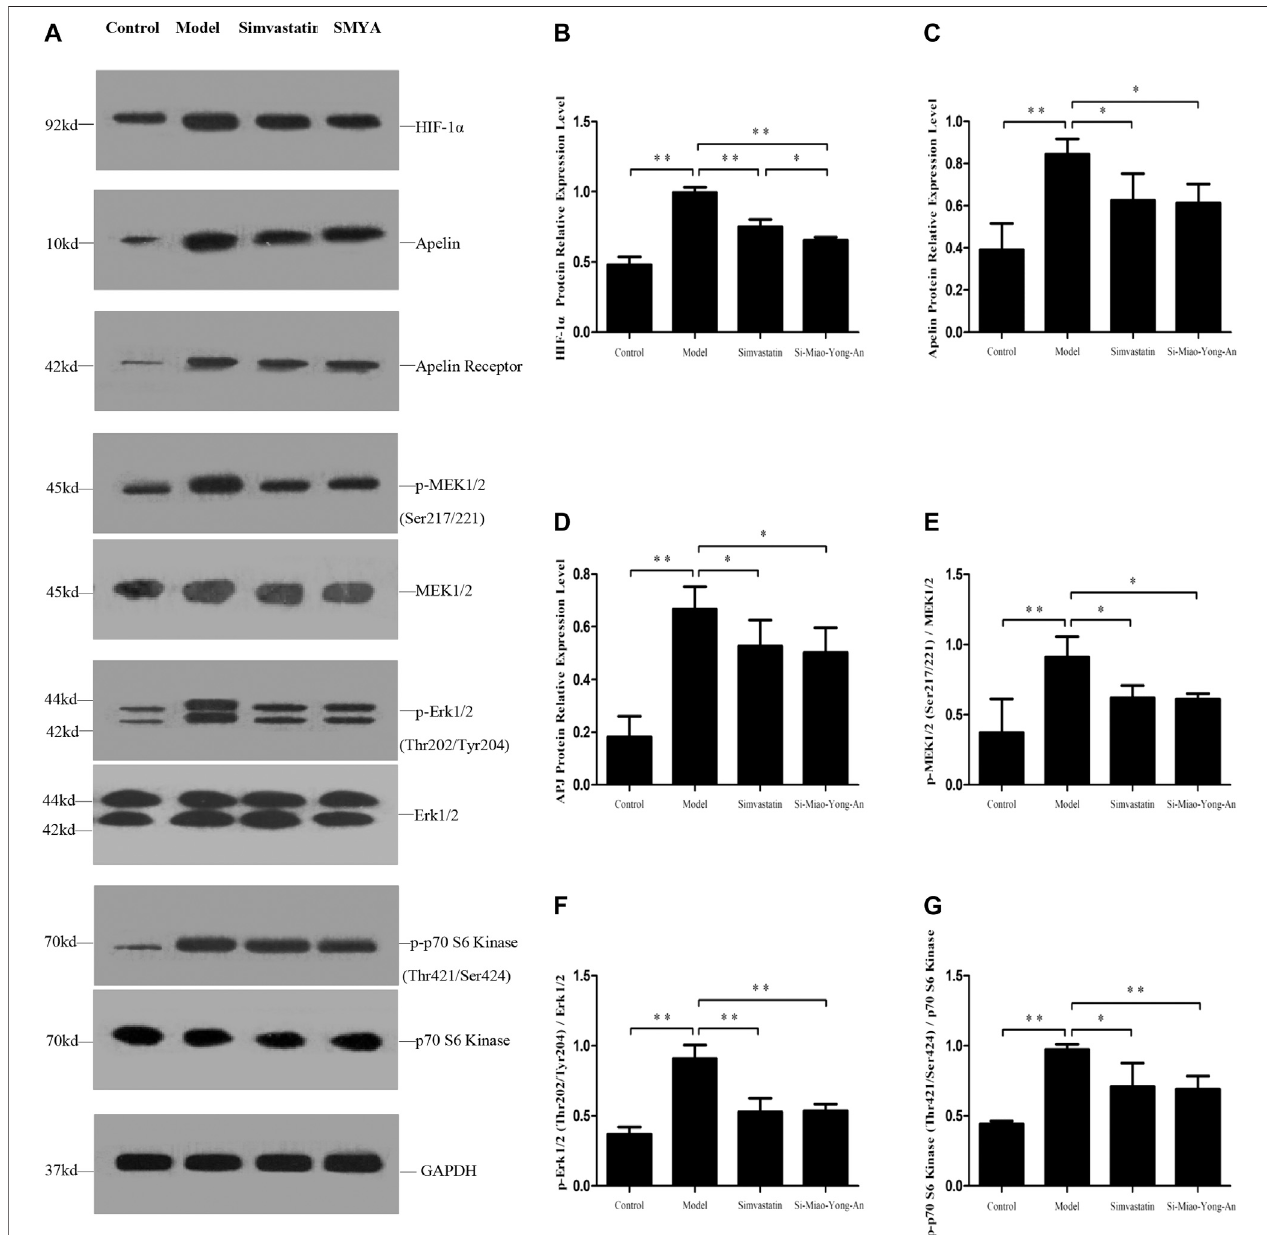
FIGURE7| Effect ofSMYAon HIF-1 α -Apelin/APJSignal Pathway. (A) Westernblotwasapplied todetect thekeyproteins ofHIF-1 α -Apelin/APJsignalpathway in aorta of each group. B – G: Semi-quantitative analysis of the results. *p < 0.05, **p < 0.01.